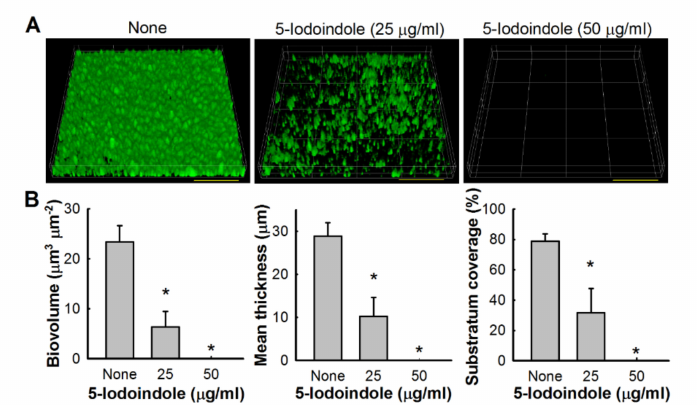
Figure 2. Biofilm inhibition of A. baumannii ATCC 17978 by 5-iodoindole. ( A ) Confocal Laser Scanning Microscopy observations of biofilm inhibition by 5-iodoindole. Scale bar = 50 µ m; ( B ) Biofilm biomasses, mean thicknesses, and substratum coverages were quantified by COMSTAT analysis. Error bars represent standard deviation. * p < 0.05 versus untreated controls.